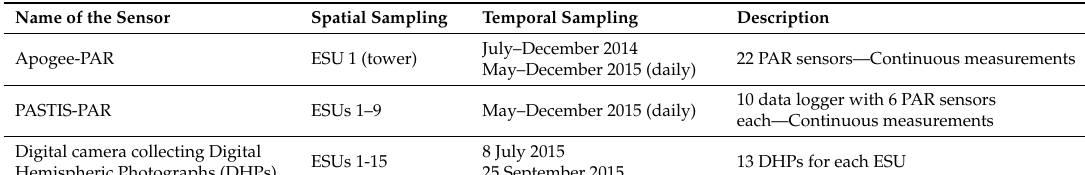
Table 3. Specifications of ground data sampling in the study.